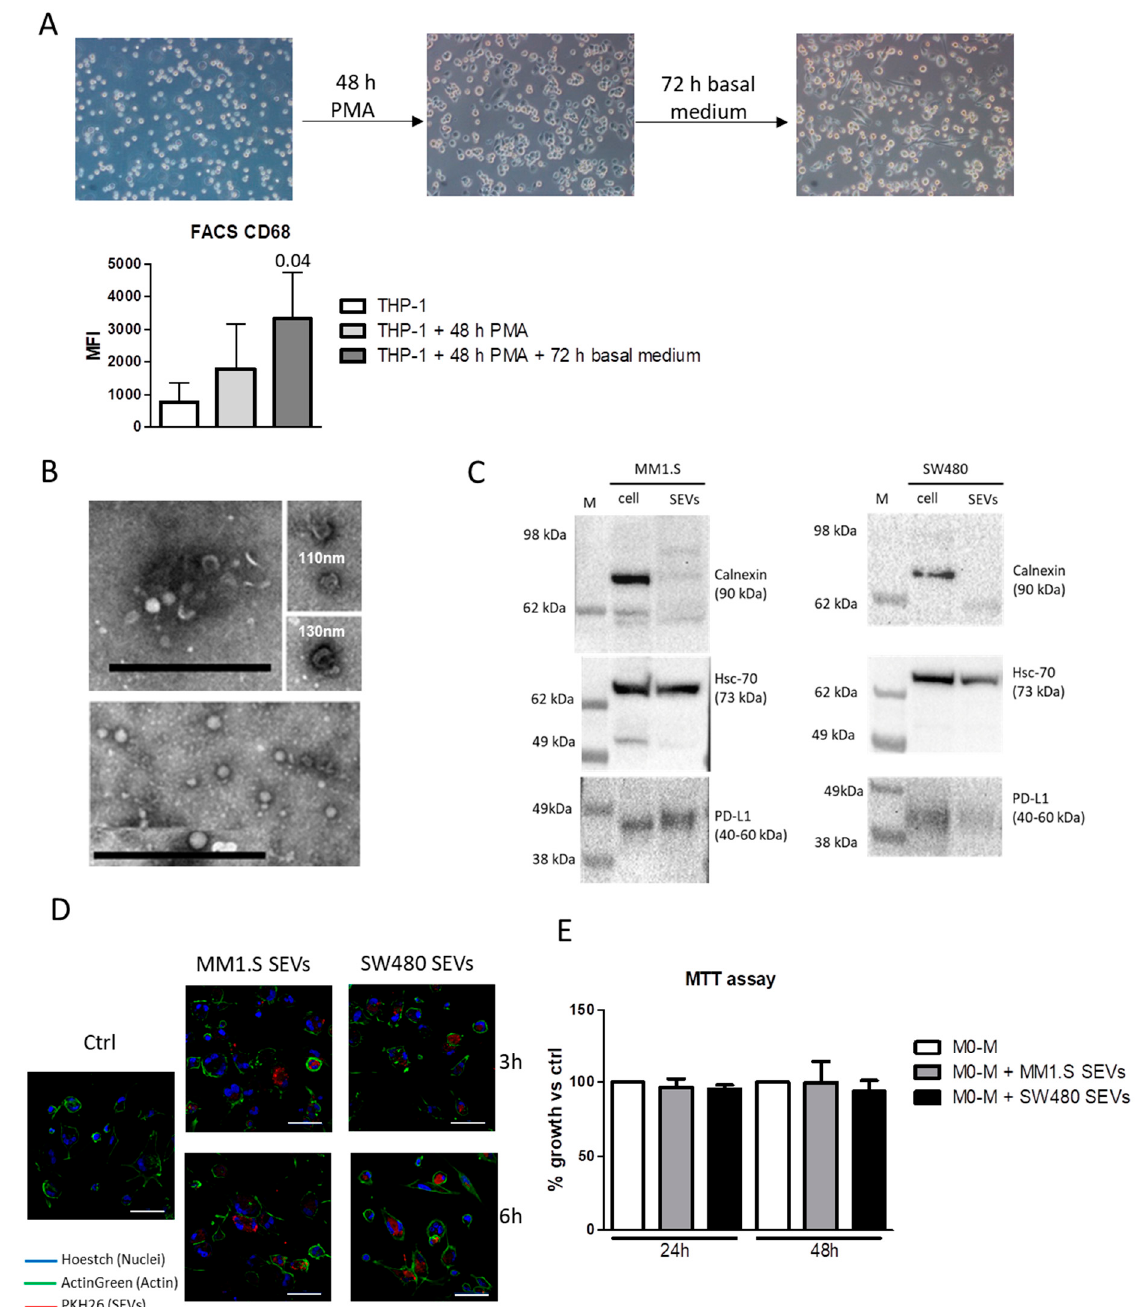
Figure 1. ( A , upper panel) Representative images of THP-1 monocytes before and after differentiation, acquired with a 10X objective. ( A , lower panel) FACS analysis of CD68 in THP-1 monocytes before and after differentiation with Phorbol 12-myristate 13-acetate (PMA). The statistical significance of the differences was analyzed using a two-tailed Student’s t -test. The reported values are the mean ± standard deviation of three replicates. ( B ) Representative TEM micrographs showing the SEVs isolated from the culture medium of SW480 (upper panel) and MM1.S (lower panel); the insets show details of the single vesicles with their measurements in corresponding images representing the diameter. Scale bar: 1 µm ( C ) Western Blot analysis of Calnexin, HSC-70, and PD-L1 in MM1.S and SW480 cell lysates and the derived SEVs. ( D ) Cellular internalization of MM1.S and SW480-derived SEVs into M0 macrophages (M0-M) was analyzed by confocal microscopy Nikon A1. The median focal plane is reported in the figure. M0-M were incubated for 3 and 6 h with MM1.S and SW480 SEVs labeled with PKH26 (red). M0-M cells were stained with ActinGreen (green), and nuclear counterstaining was performed using Hoescht (blue). (scale bar = 50 µM). ( E ) MTT assay of M0-M treated with MM1.S- and SW480-SEVs for 24 and 48 h. The reported values are the mean ± standard deviation of four replicates.